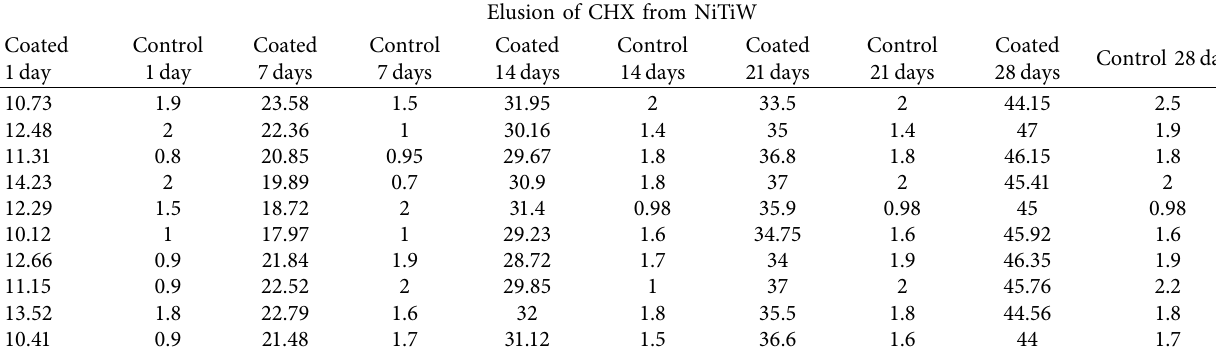
Table 4: Te raw data of CHX elusion of